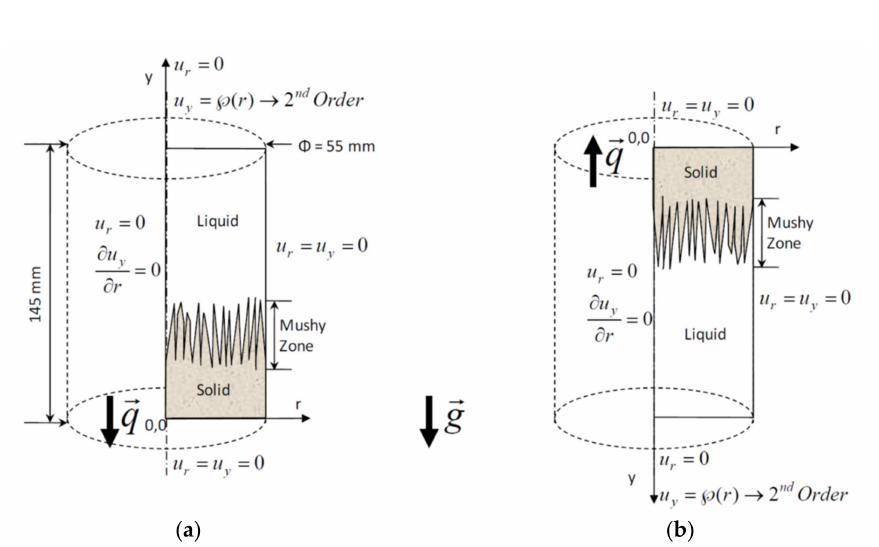
Figure 3. Velocity boundary conditions in the simulation domains presented in Figure 2. ( a ) upward and ( b ) downward